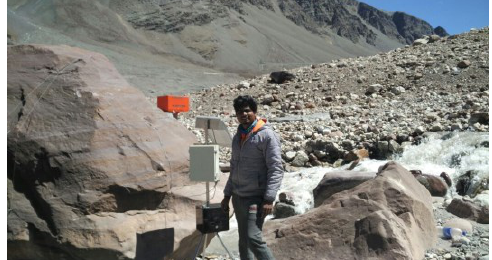
Figure 21. Installation of DWLR at downstream of Patsio glacier, H.P. (Oct. 2016). Instrument worked till April 2017, and was damaged due to heavy snowfall in 2017 winter season.